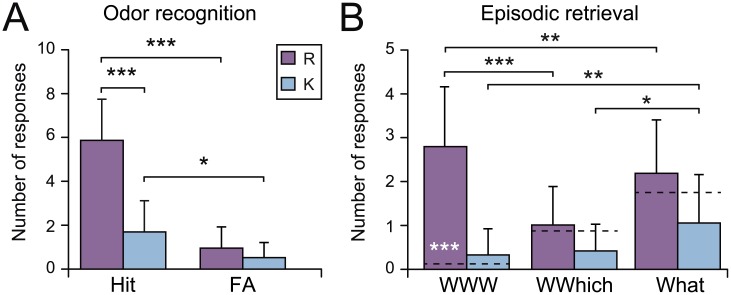
Memory performance.Mean numbers of R/K responses as a function of A) the accurate (Hit) and inaccurate (FA) odor recognition, and B) the episodic retrieval responses (WWW, WWhich and What). The dashed horizontal lines indicate the chance levels of the WWW, WWhich and What responses. Vertical bars represent the SD; in black, * p < 0.05, ** p < 0.01, *** p < 0.001; in white, *** p < 0.001 above chance level.